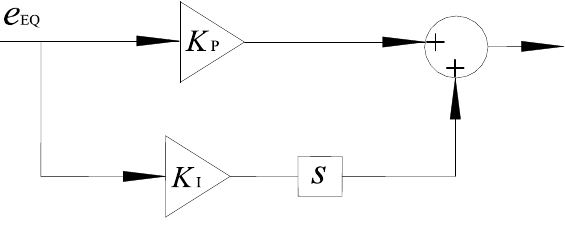
Figure 13. Equivalent force controller.